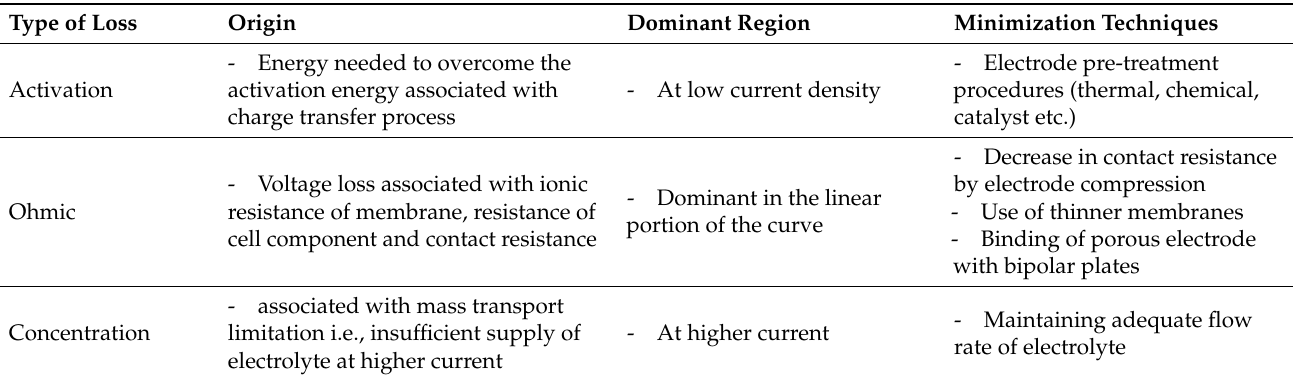
Table 2. Losses obtained from the polarization